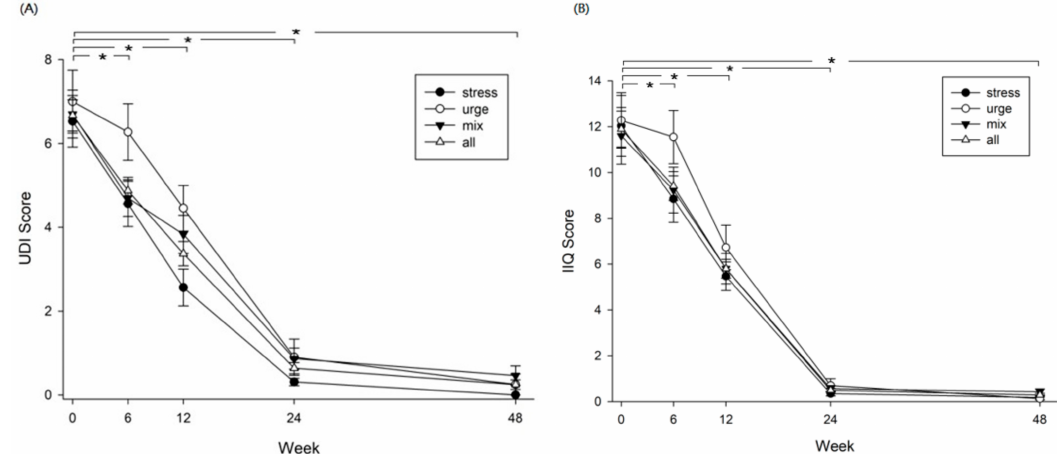
Figure 5. Urinary incontinence and impact on quality of life assessed with ( A ) the Short-form Urogenital Distress Inventory (UDI-6) and ( B ) the Short-form Incontinence Impact Questionnaire-7 (IIQ-7). Significant differences are shown in four groups at week 6 vs. baseline ( p = 0.000), week 12 vs. baseline ( p = 0.000), week 24 vs. baseline ( p = 0.000), and week 48 vs. baseline ( p = 0.000) in both ( A , B ); *, p <